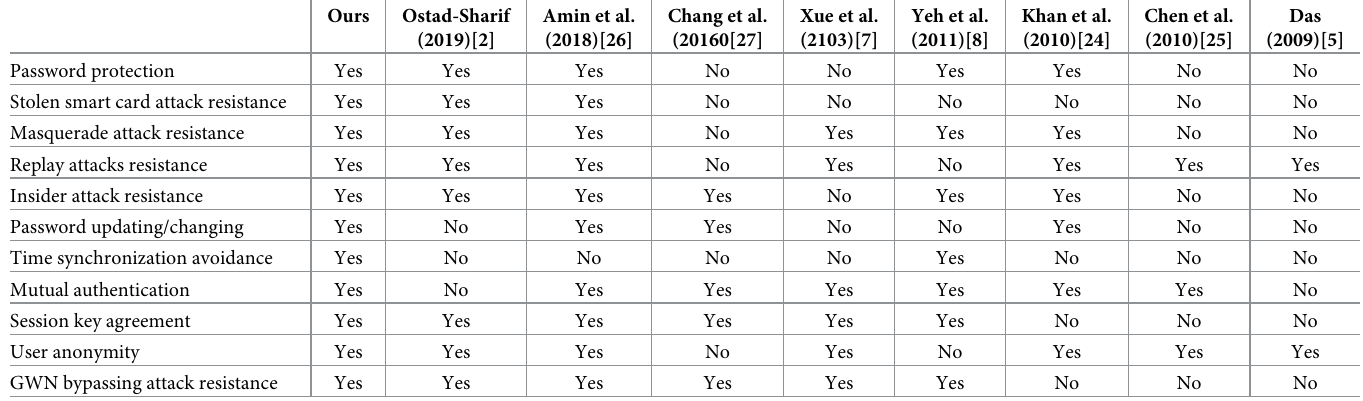
Table 3. Functionality comparison of our scheme with other related schemes.